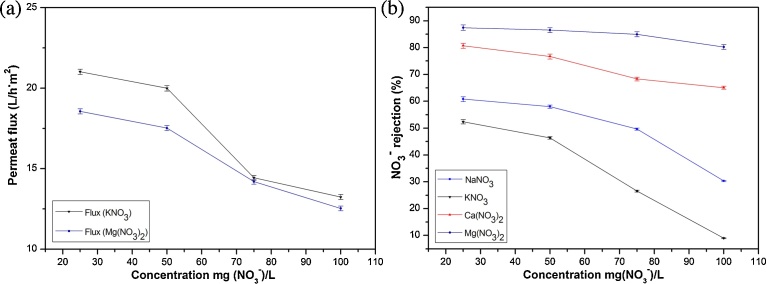
Effects of concentration on permeate flux (a) and on NO3− rejection for binary solutions KNO3, NaNO3, Ca(NO3)2 and Mg(NO3)2 (b) (at ΔP = 6 bar, and natural pH).